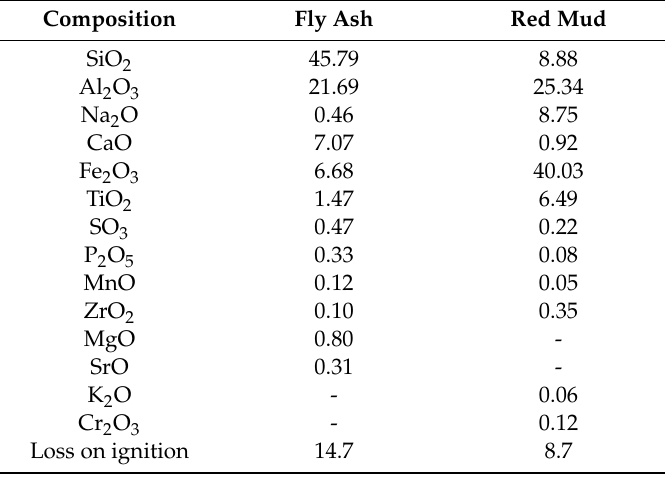
Table 1. Chemical composition (wt%) of fly ash and red